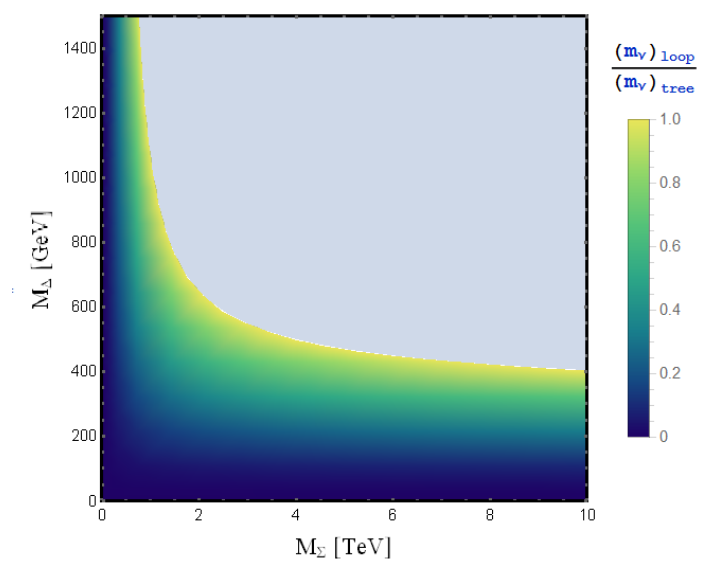
Figure 3 . Contour plot of the ratio m loop